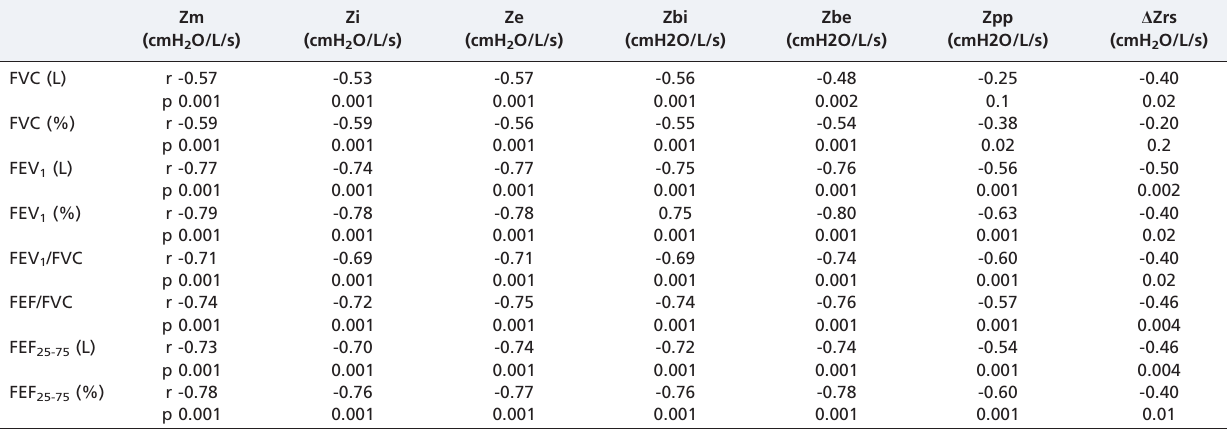
Table 4 - Pearson correlation coefficient (r), and p-value (p) between FOT and spirometry.